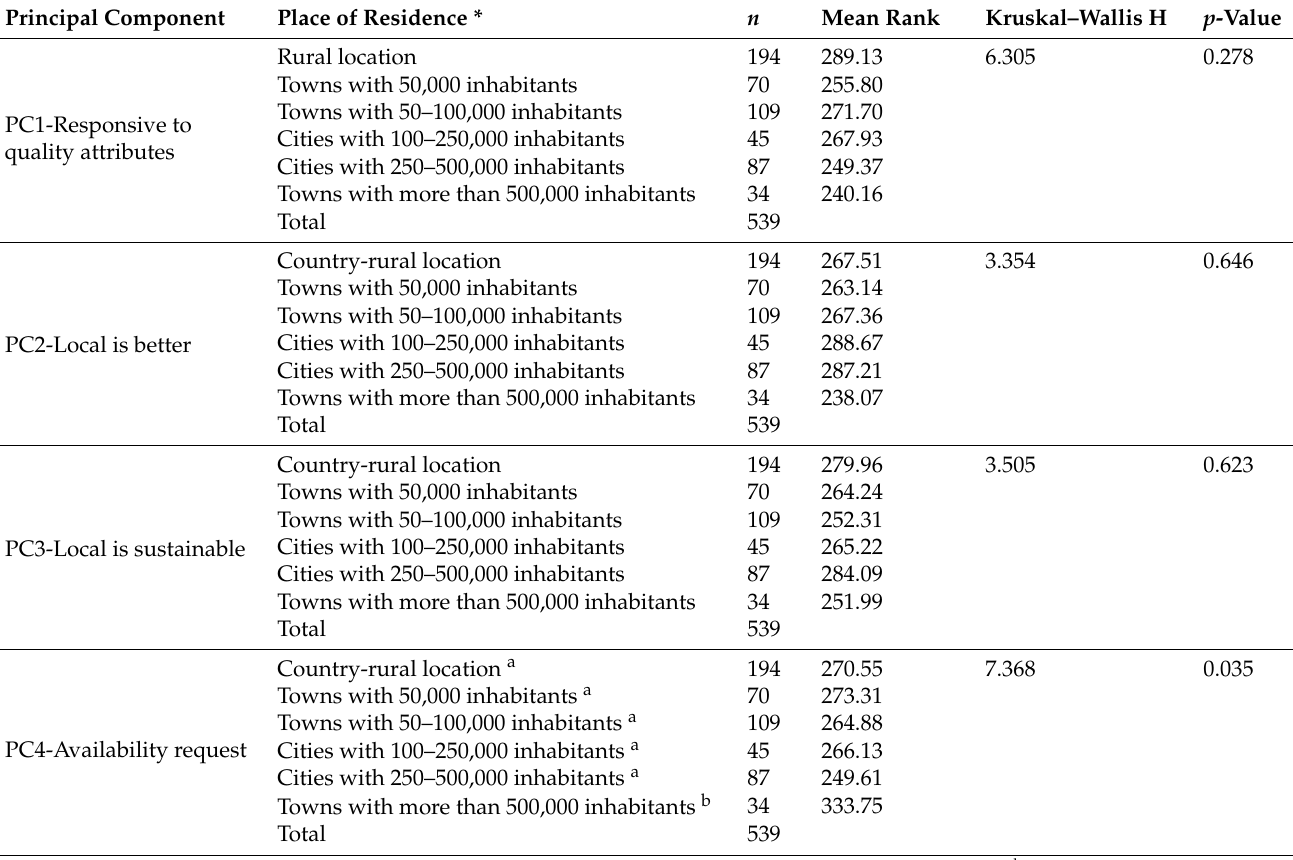
Table 5. Effect of place of residence dimension on the principal components’ definition.